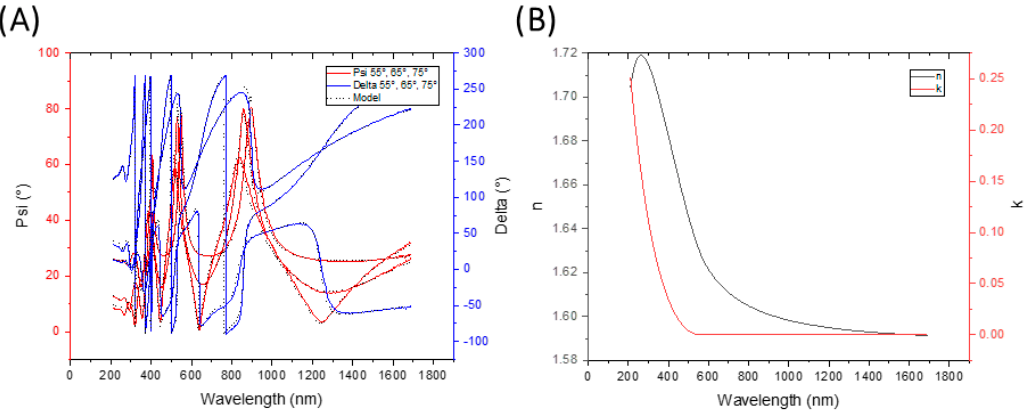
Figure 3. Optical properties of plasma polymerized nylon. ( A ) Modelling of spectroscopic ellipsometry, ( B ) Plots of refractive index and extinction coefficient.